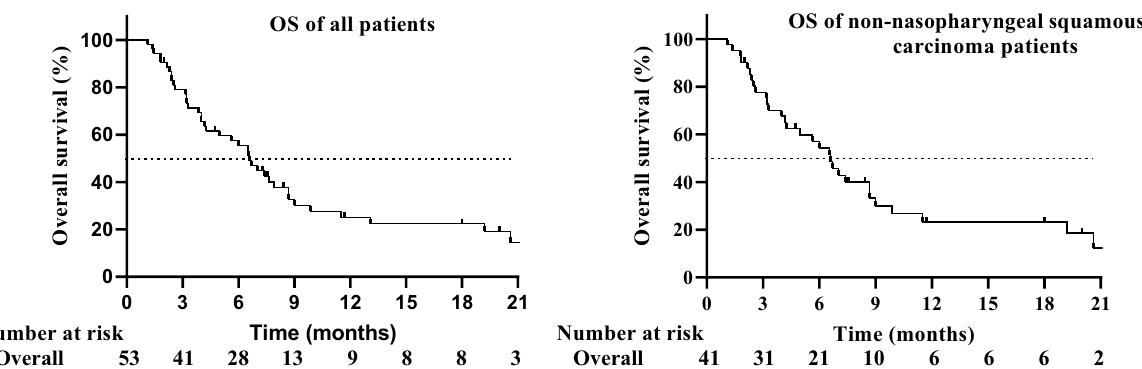
Figure 2. Kaplan–Meier graph for progression-free survival (OS) of all patients (n = 53) and non- nasopharyngeal squamous cell carcinoma patients (n = 41): Median OS of all people was 6.6 months (95%